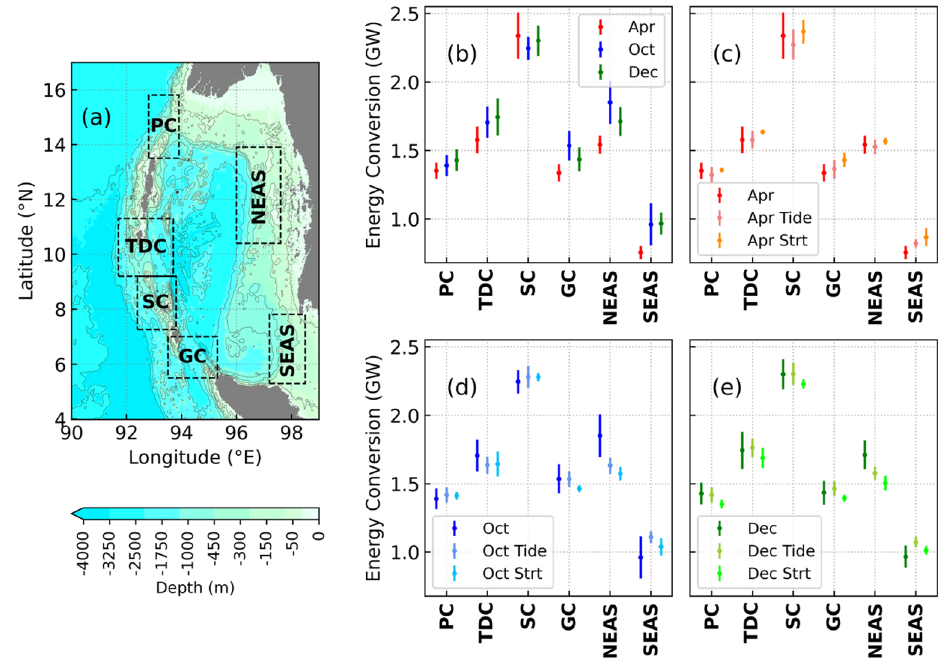
Figure 6. ( a ) Bathymetry of the Andaman Sea showing the sub-regions. ( b – e ) Standard deviation of semidiurnal IT energy conversion for different sets of experiments. ‘Apr’, ‘Oct’, and ‘Dec’ are set of realistic experiments. ‘Apr Tide’, ‘Oct Tide’, and ‘Dec Tide’ are set of experiments to quantify the effect of tidal forcing. ‘Apr Strt’, ‘Oct Strt’, and ‘Dec Strt’ are set of experiments to quantify the effect of stratification